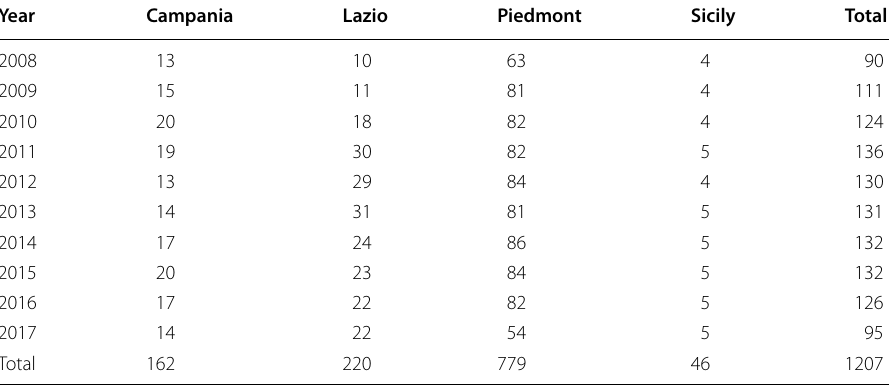
Table 1 Farm sample (number of